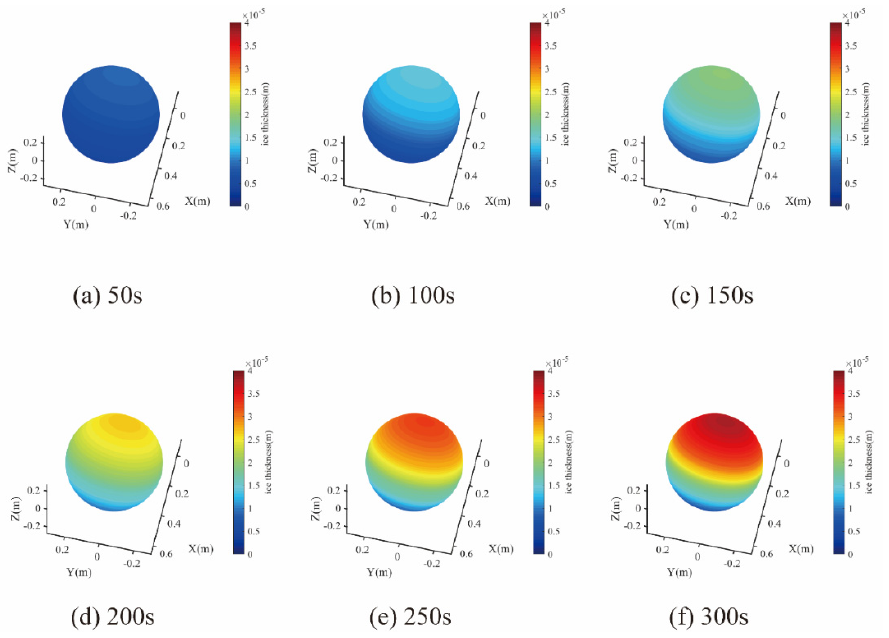
Figure 4. Ice accretion of the scaled airship at ( a ) 50 s, ( b ) 100 s, ( c ) 150 s, ( d ) 200 s, ( e ) 250 s, and ( f ) 300 s during condition